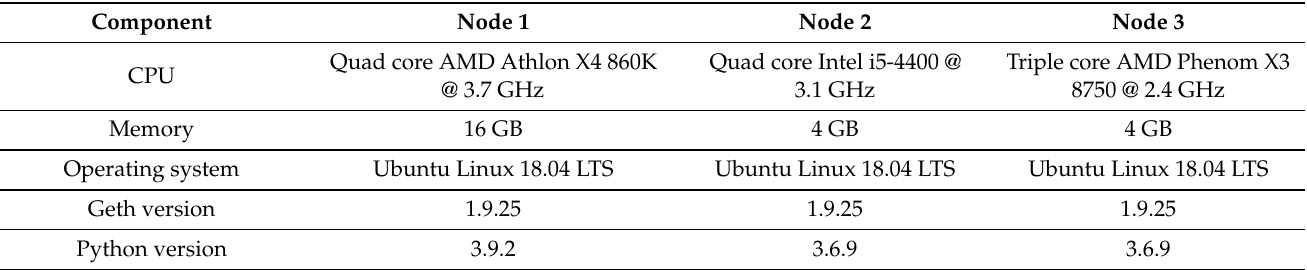
Table 3. Proposed framework node